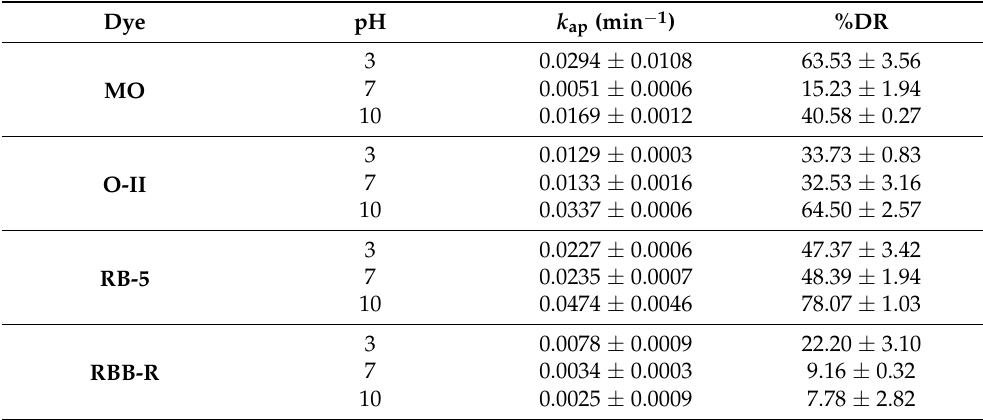
Table 1. Apparent rate constant and percentage of dye removal (at 30 min) of the UV AOP of dyes (the standard deviations of at least three independent repetitions are shown). The fitting of the integrated first-order kinetics resulted in R 2 > 0.98.